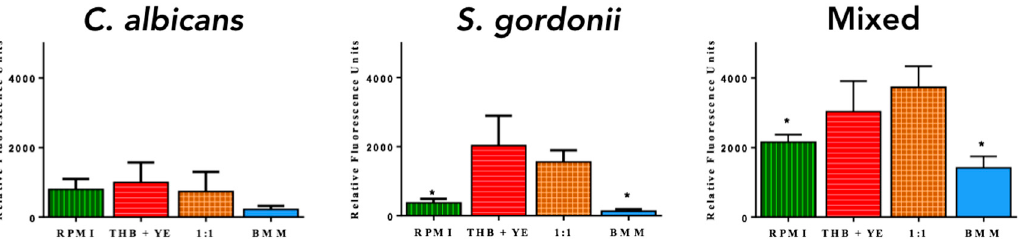
Figure 1. Metabolic activity after 24 h incubation of C. albicans and S. gordonii single- and dual-species biofilms formed on titanium. Biofilms were grown in RPMI 1640, THB + 0.02% YE, 1:1 v / v RPMI/THB + YE and BMM synthetic saliva in a 48-well plate containing titanium discs for 24 h. After incubation, discs were placed inside a new, sterile 48-well plate and viability was measured by Presto Blue TM fluorescence; n = 3. Error bars represent standard deviations. * indicates statistically significant differences.